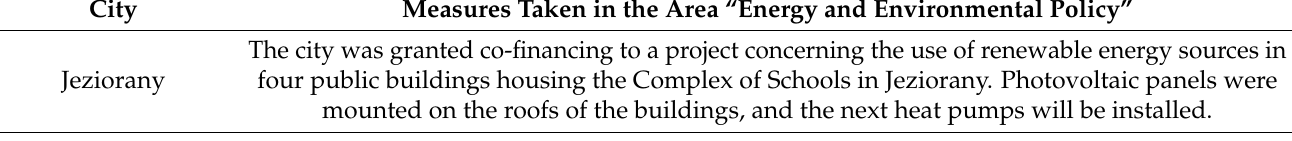
Table 4. Examples of measures implemented in the area “energy and environmental policy” in the selected member cities of the Polish National Cittaslow